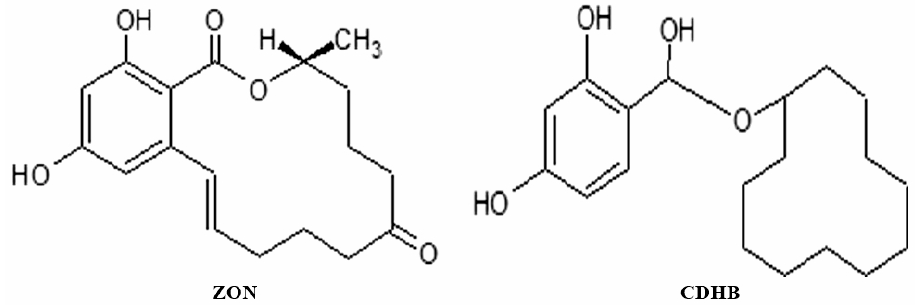
Figure 2. Structural formulae of the zearalenone (ZON) and a dummy template (cyclododecyl-2,4- (cyclododecyl-2,4-dihydroxybenzoate, CDHB). dihydroxybenzoate, CDHB).